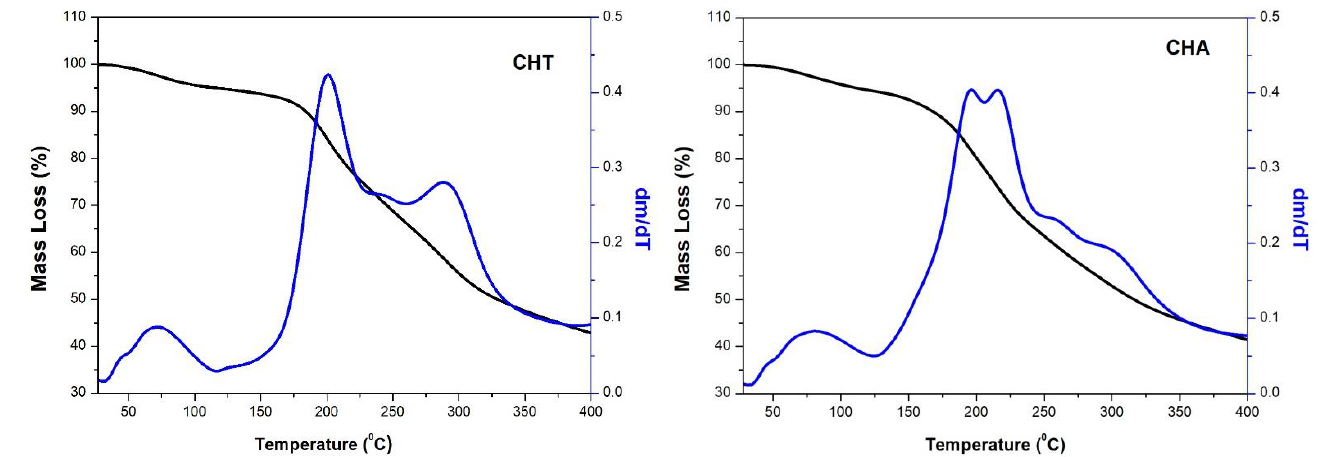
Figure 5. TGA and DTG thermograms of CHT and CHA.